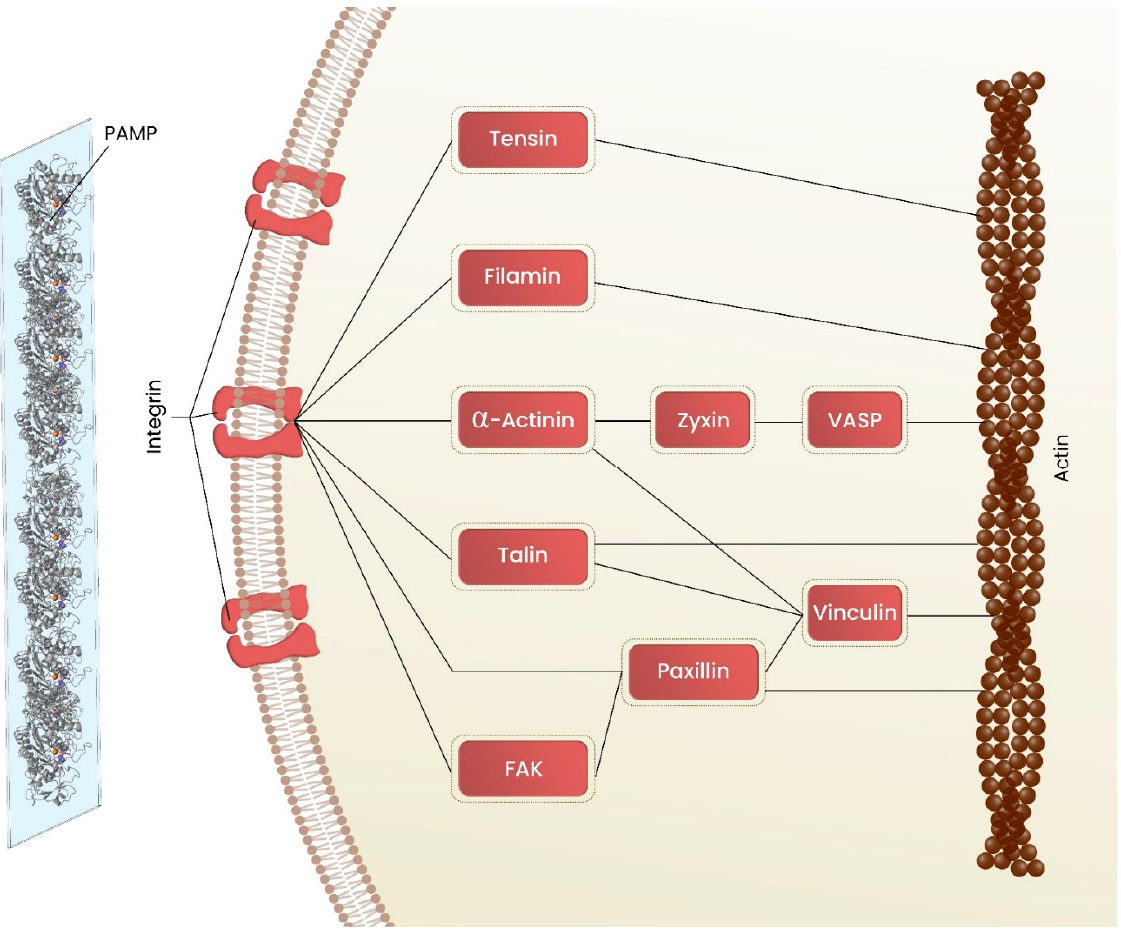
Figure 3. Organization of molecular connections mediating linkages between actin cytoskeleton and transmembrane adhesion receptors, integrins, at the cell–ECM adhesion sites.